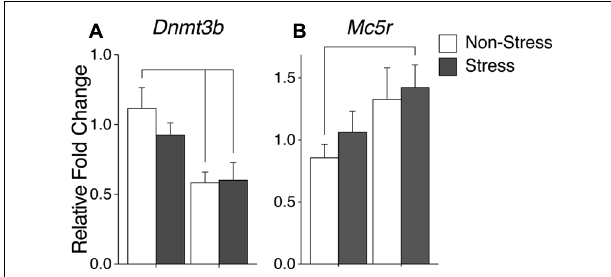
FIGURE 5 | Gene expression in the ventromedial nucleus (VMN). Relative gene expression of (A) Epigenetic modification enzyme Dnmt3b which shows a significant decrease of expression due to ancestral vinclozolin exposure. (B) Peptide receptor Mc5r shows a significant expression increase inV-S animals. Lines connecting group bars signify a significant post hoc pair-wise